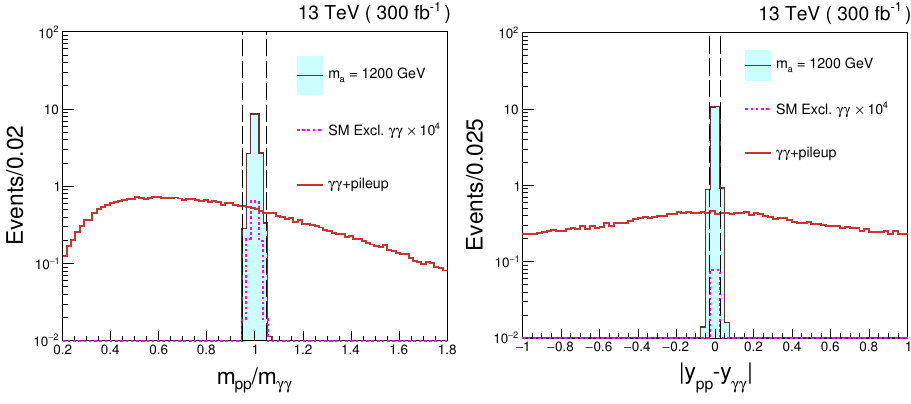
log( (cid:24) 1 ) distribution 2 (cid:24) 2